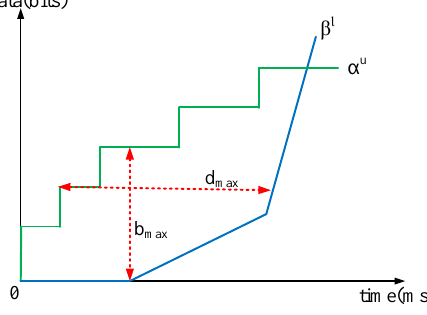
Figure 10. Abstract representation of delay and